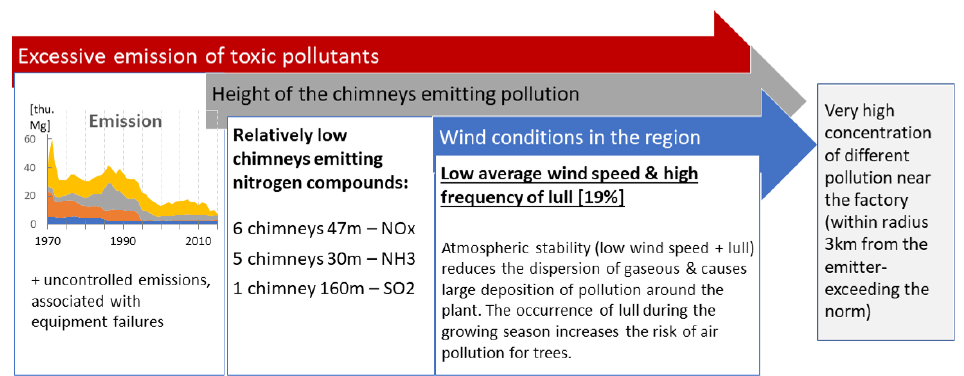
Figure 9. Possible factors determining the reductions in the annual ring width of the Scots pines.